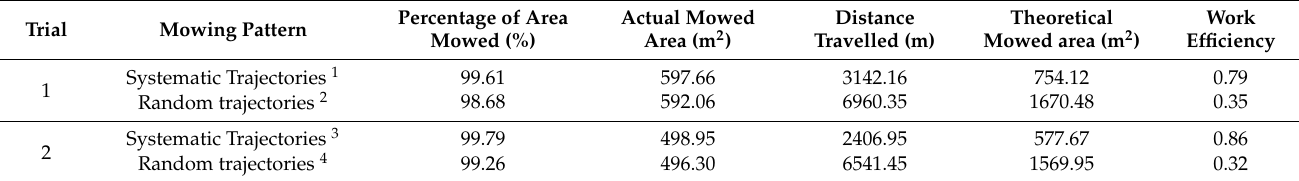
Table 3. Results for autonomous mowers’ parameters. Data were pooled over the 4 replications.